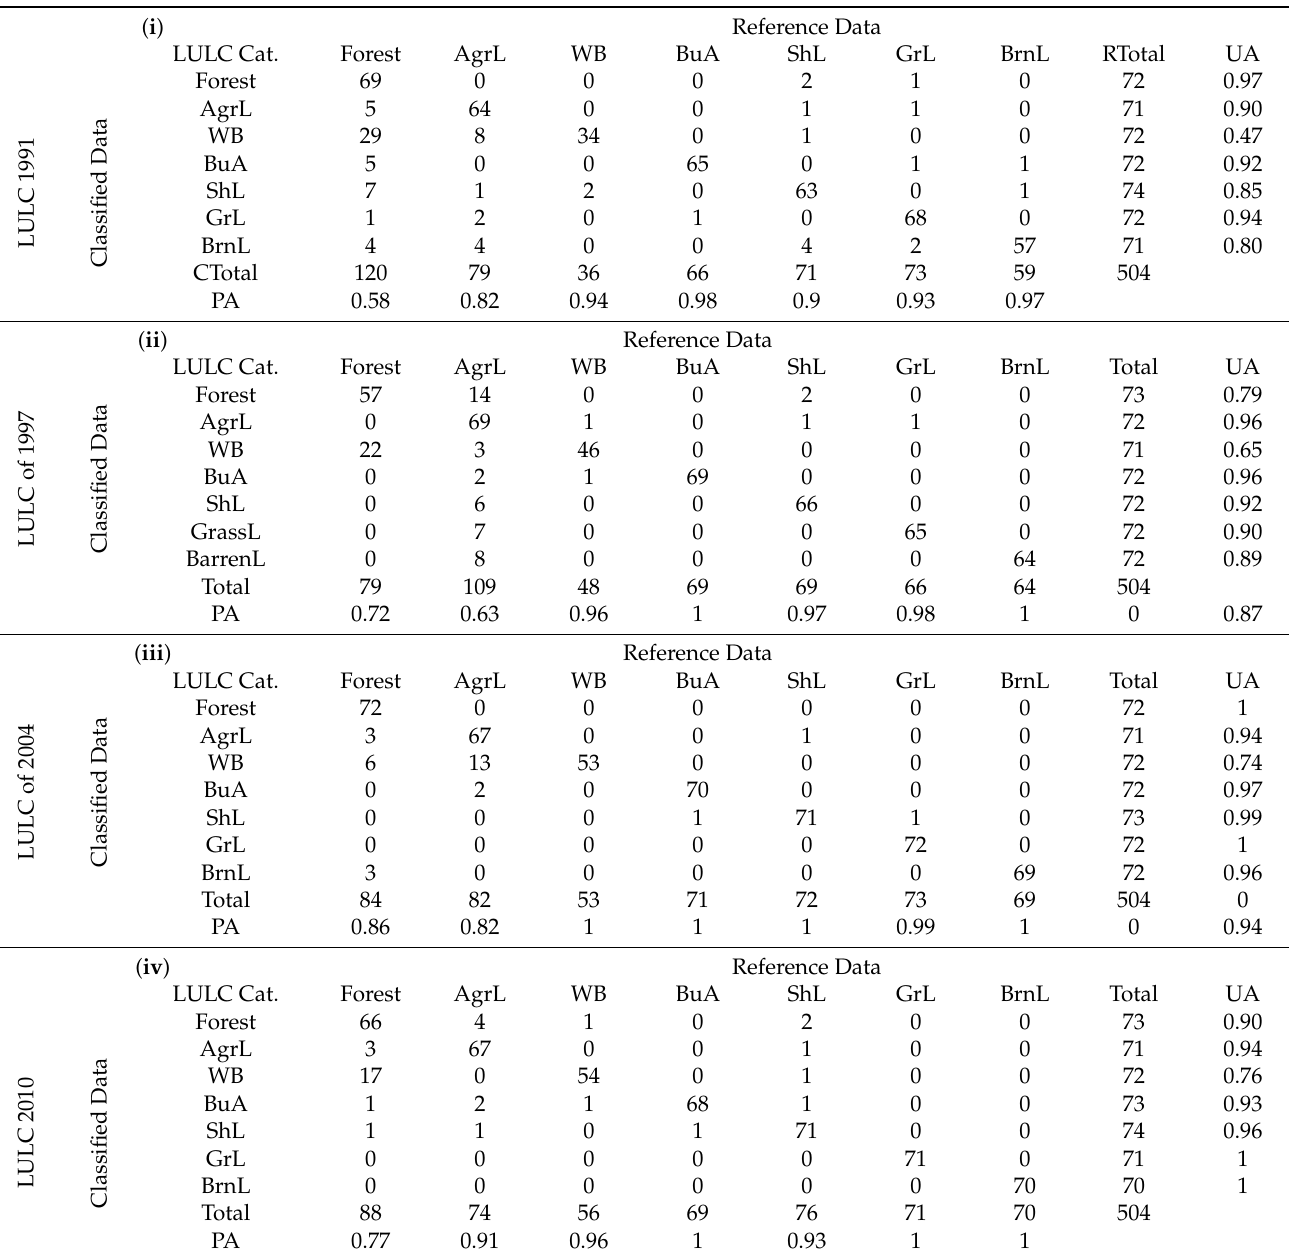
Table 3. Confusion matrixes for LULC classification (i) 1991, (ii) 1997, (iii) 2004, (iv) 2010, (v) 2016, and (vi)